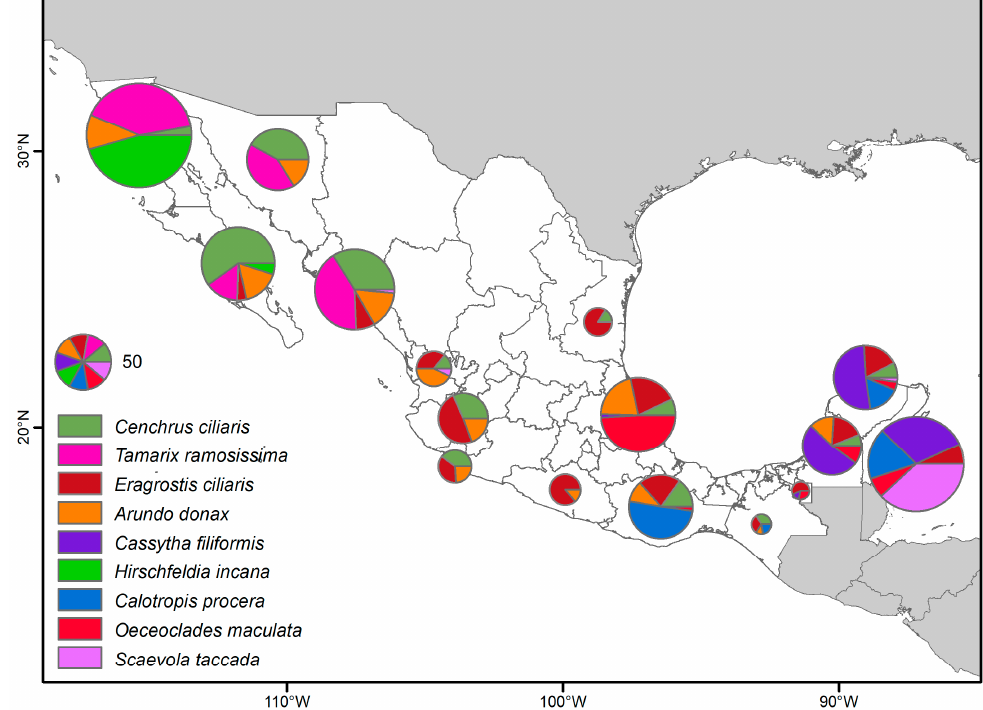
Figure 7. Distribution of invasive plant species throughout the coastal dunes of Mexico. The size of the pie chart indicates the total number of records per coastal state; each slice represents one invasive plant species, and its size is representative of the relative number of records of each.